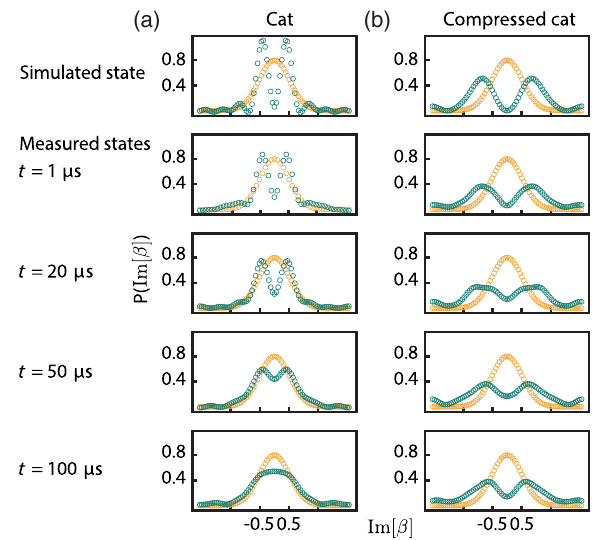
FIG. 9. Decay of sub-Planck structure. We implement a one- dimensional Fourier transformation along Im ½ ν (cid:3) ¼ 0 of the ideal (top row) and measured characteristic function. We obtain the marginal momentum distribution of Im ½ β (cid:3) for (a) cat (green) and (b) − 7 . 6 dB compressed cat (green) of different decay times, respectively, and compare the width of resulting oscillatory features to that of ideal vacuum (gold).